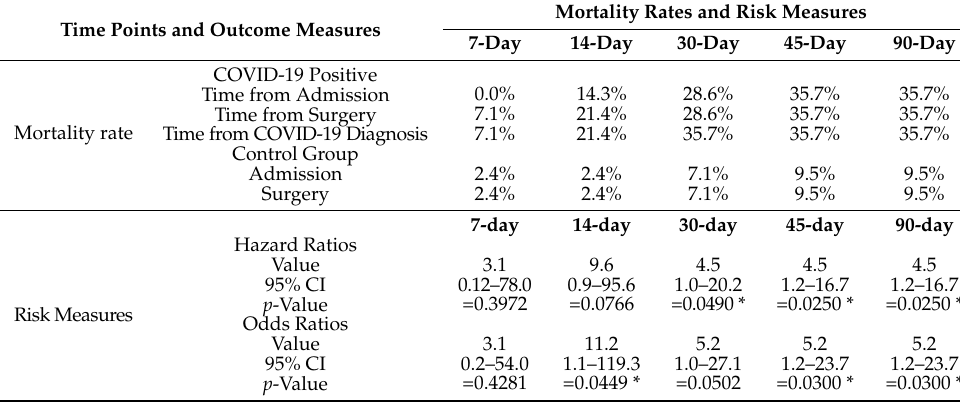
Table 4. Mortality rates and risk measures (hazard ratios and odds ratios between cases and controls) at 7, 14, 30, 45, and 90 days from hospital admission, surgery, and diagnosis of COVID-19.